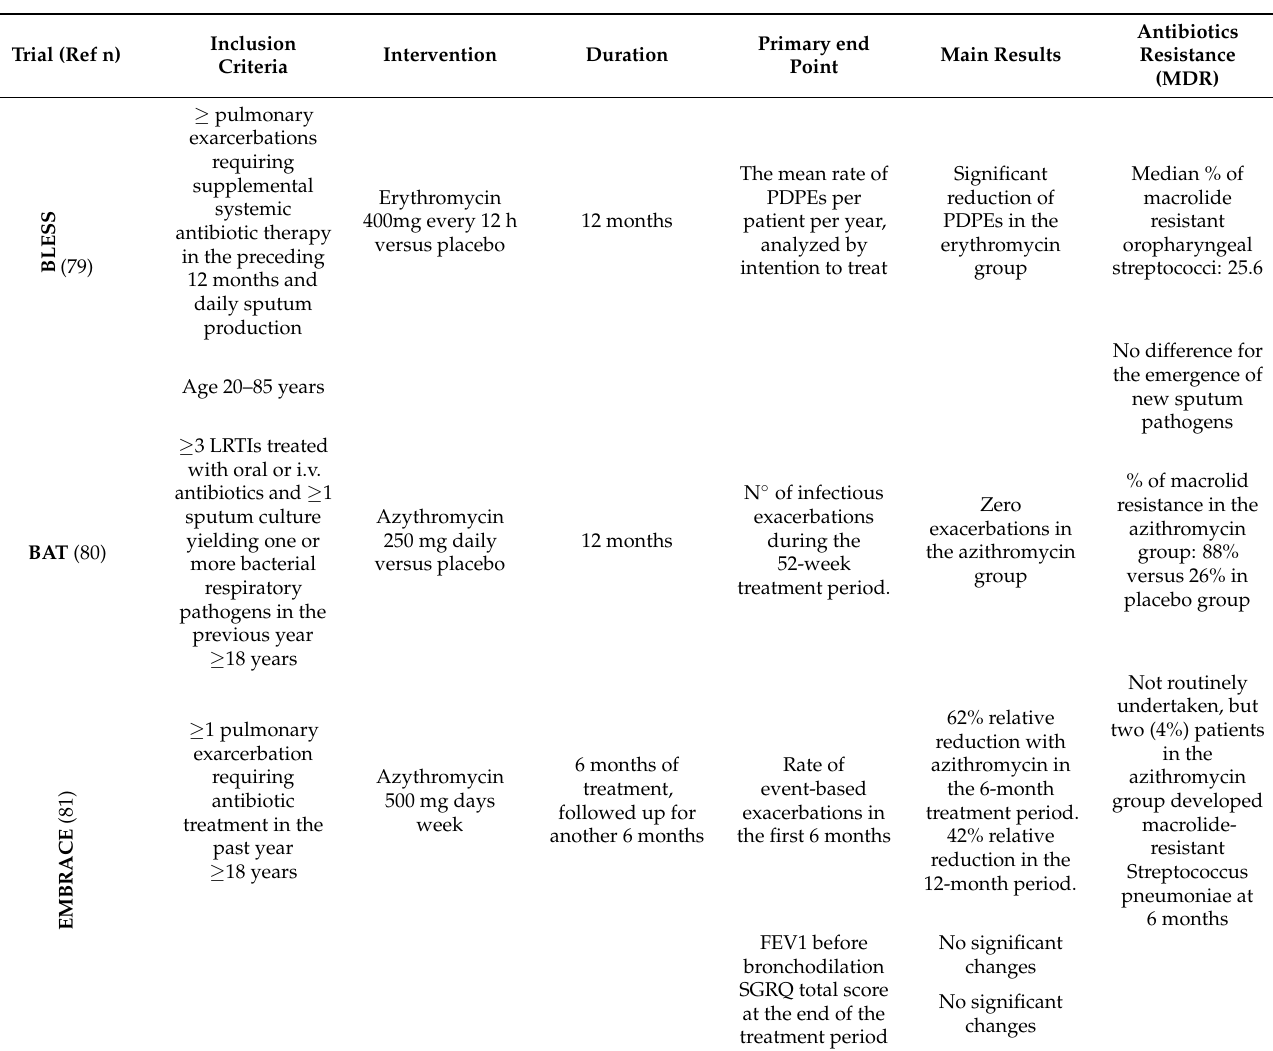
Table 4. Trials with long-term macrolides in